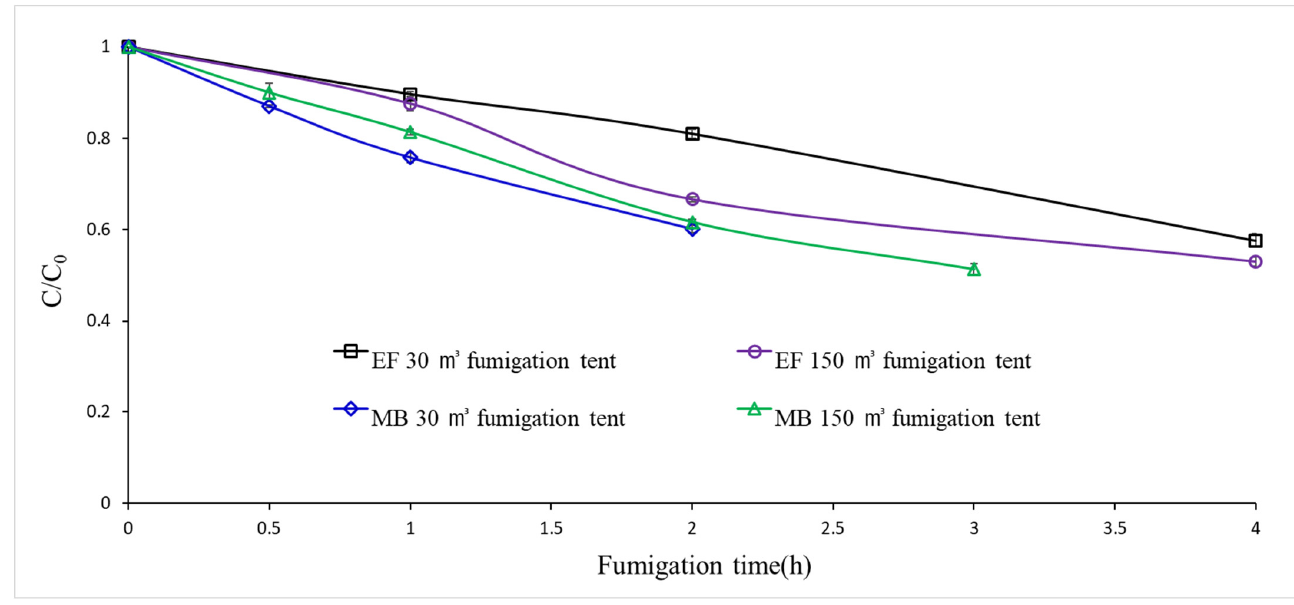
Figure 2. Concentration loss of methyl bromide (MB) and ethyl formate (EF) (C/C 0 ) in 30 and 150 m 3 fumigation tents with a 5% loading ratio ( w / v ) of imported orchids. MB was treated at 48 g/m 3 at 15 ± 1 °C for 2 h during 30 m 3 tent trials and for 3 h during 150 m 3 tent trials and EF was treated at 35 g/m 3 for 4 h at 15 ± 1 °C in both sizes of fumigation tents. EF concentration was checked at 0.1,